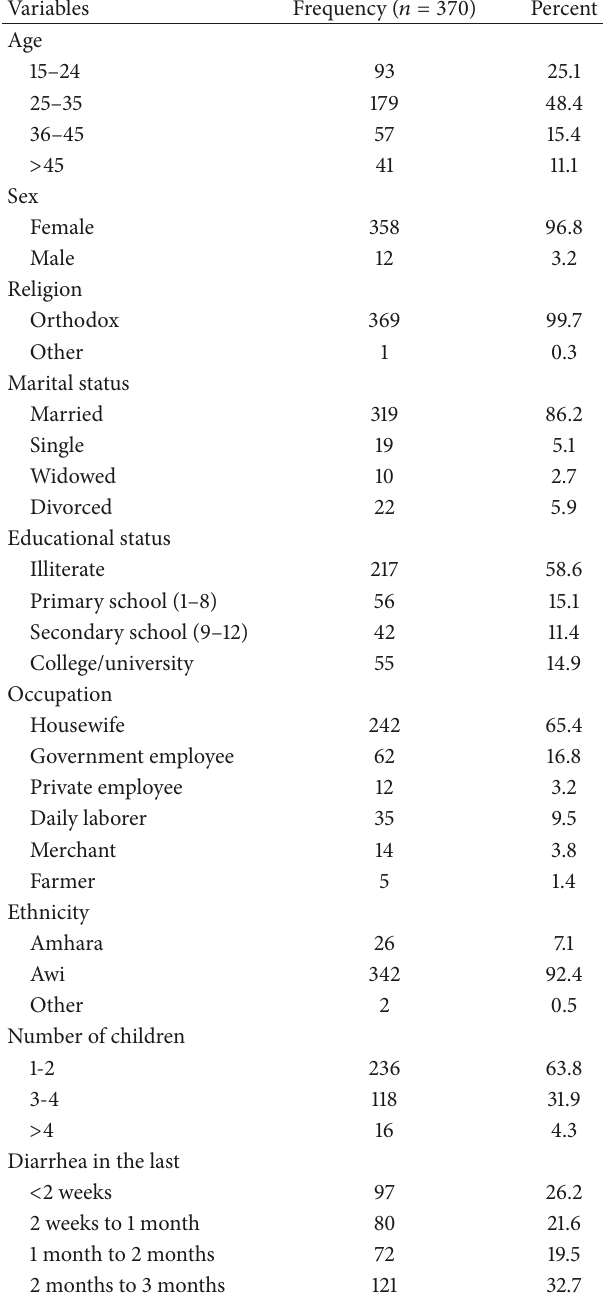
Table 1: Sociodemographic characteristics of caregivers attending under-five clinic in the Fagita Lekoma district, Awi Zone, Amhara Regional State, Northwest Ethiopia, 2016 ( 𝑛 = 370